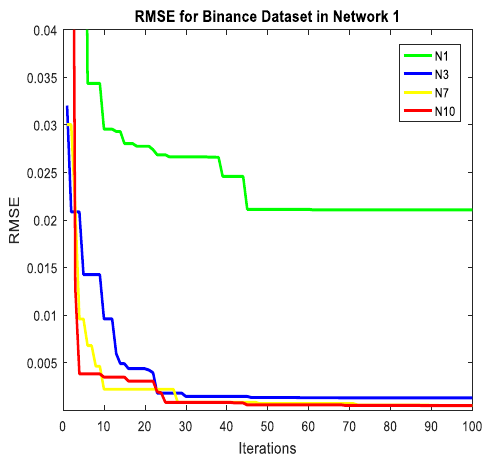
Figure 10. Fitness plot for Binance dataset .